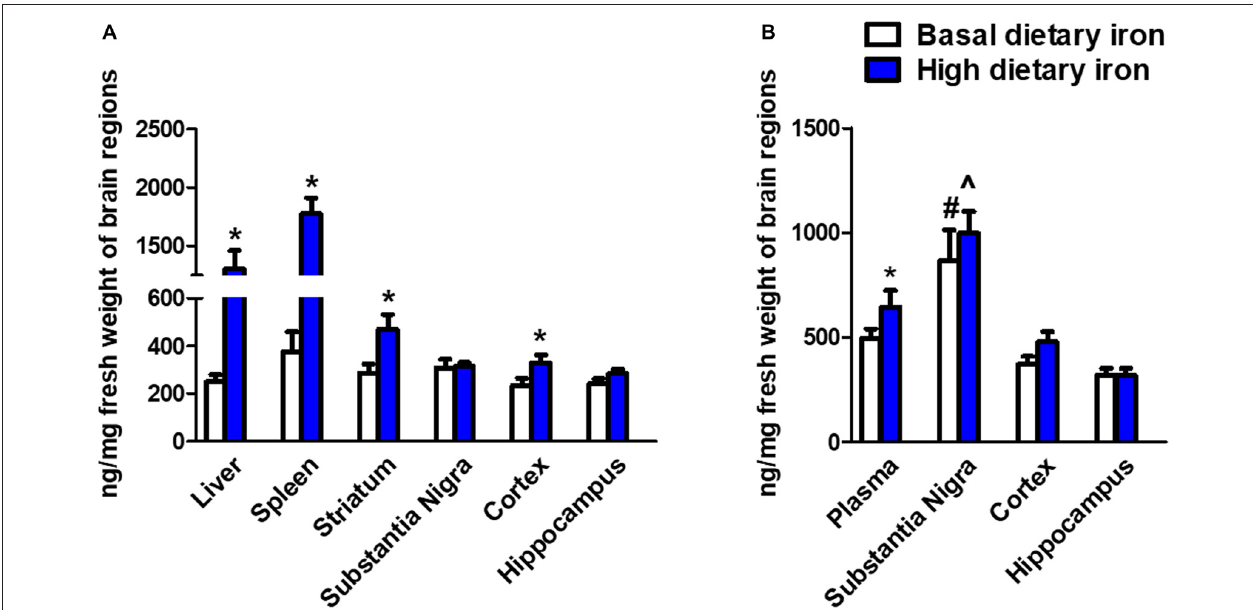
FIGURE 4 | Iron contents in peripheral organs and brain regions in 2-month and 12-month mice with dietary iron supplement for 3 months. (A) Iron contents in peripheral organs and brain regions in 2-month mice with dietary iron supplement: Iron contents were increased in the liver and spleen (peripheral organs) in 2-month WT mice with high dietary iron supplement for 3 months. Although no changes were observed in the other brain regions, iron contents were elevated in the cortex and striatum of 2-month mice with high dietary iron for 3 months. Each bar represented the mean ± SEM. ∗ P < 0.05, compared with the corresponding basal dietary iron group; n = 6. (B) Iron contents in peripheral organs and brain regions in 12-month mice with dietary iron supplement: Iron contents were increased in the plasma. Iron contents in the SN were obviously higher than the other brain regions in 12-month mice with basal dietary iron and high dietary iron for 3 months. Each bar represented the mean ± SEM. ∗ P < 0.05, compared with the corresponding basal dietary iron group; # P < 0.05, compared with the other brain regions of mice with basal dietary iron; ∧ P < 0.05, compared with the other brain regions of mice with high dietary iron; n =